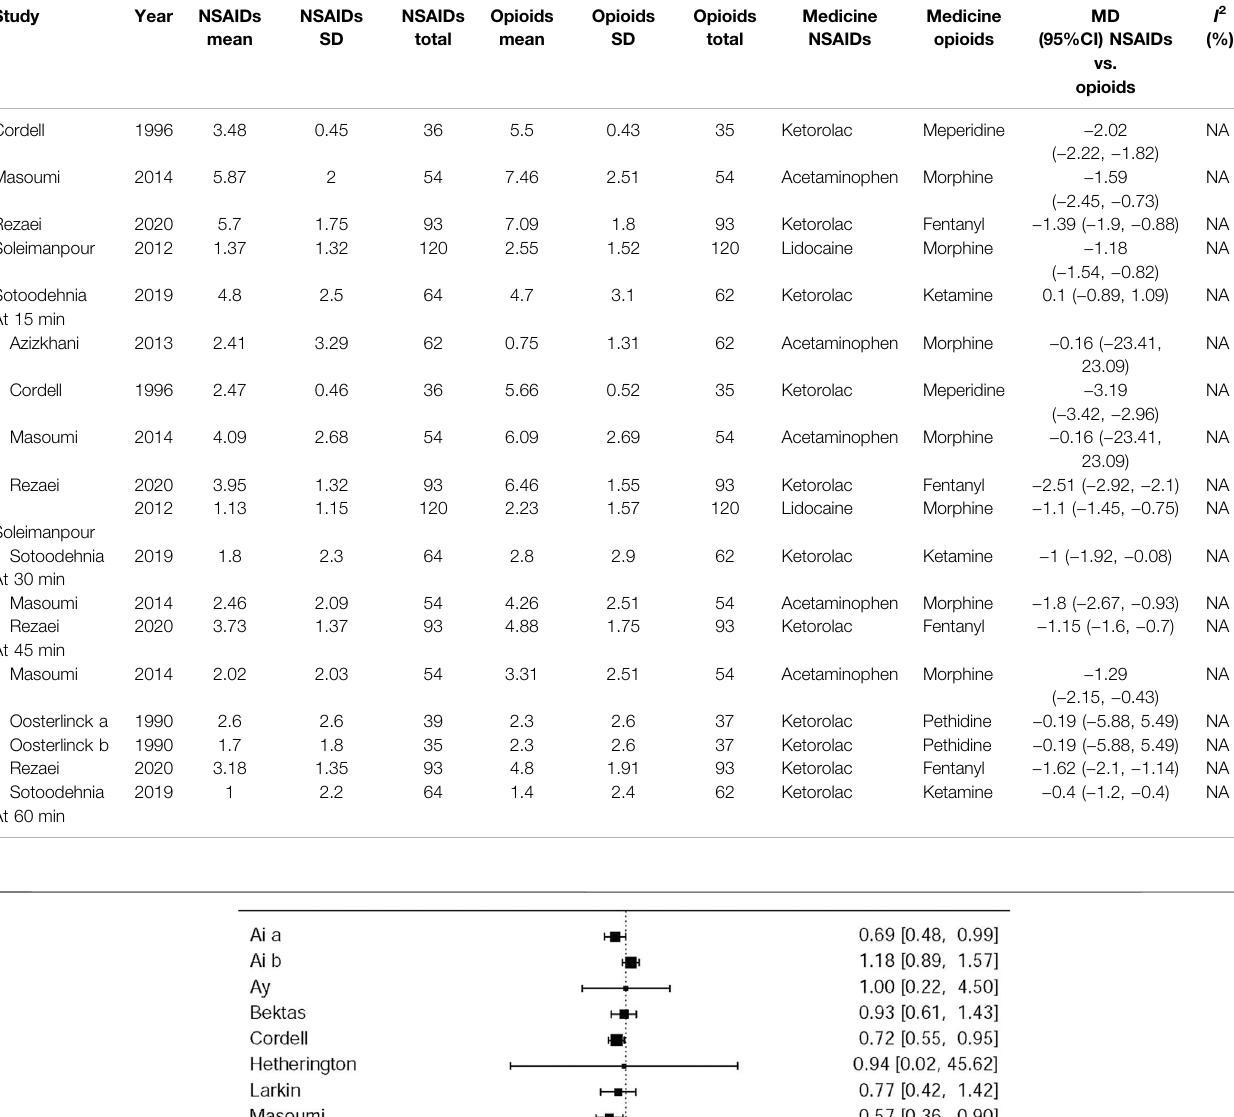
TABLE 4 | Subgroup analysis of NSAIDs and opioids of the VAS over different time periods. Study